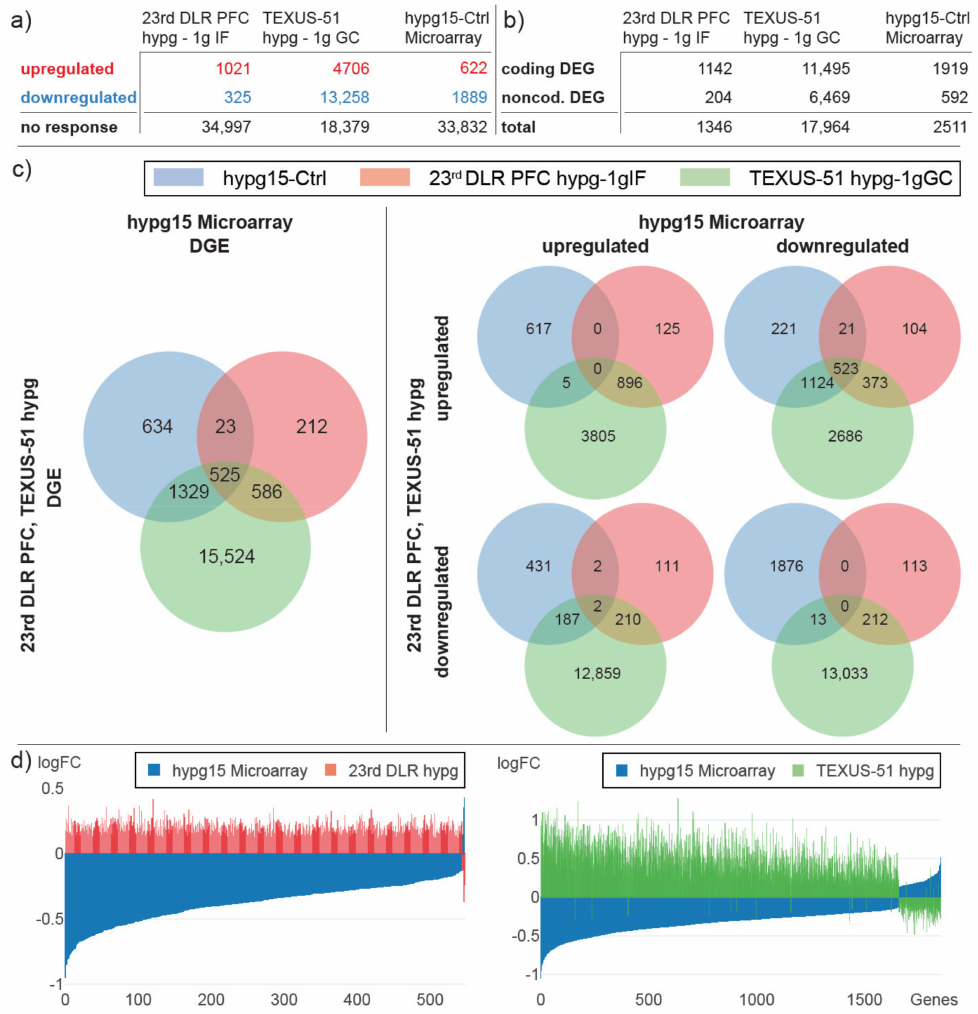
Figure 5. Cross-comparison of transcriptional behavior with short hypergravity microarray tran- scriptomics data sets, 23rd DLR PFC 20 s 1.8 × g hypergravity (hypg) vs. 1 × g in flight control (1gIF) and TEXUS-51 75 s ~9 × g baseline hypergravity (hypg) vs. 1 × g ground control (1gGC). 15 min hy- pergravity, microarray data only. ( a ) Significantly up- and downregulated genes and non-responsive genes for the two previous data sets and the hypg15 data set from this study, microarray data set only. ( b ) Significantly differential expressed genes, aggregated by protein-coding genes and noncoding genes for all three data sets. ( c ) Overlap between differentially expressed genes for all three data sets. Left: all significantly differentially expressed genes. Right: differentially expressed genes, split by upregulated and downregulated genes for the hypg15 microarray data set (horizontal axis) and by upregulated and downregulated genes for both external data sets (vertical axis). ( d ) Corresponding fold changes of genes that are differentially expressed both in hypg15 and 23rd DLR PFC hypg (left), resp. TEXUS-51 hypg (right). For each gene, two fold changes are displayed by two differentially colored bars at the same location on the horizontal